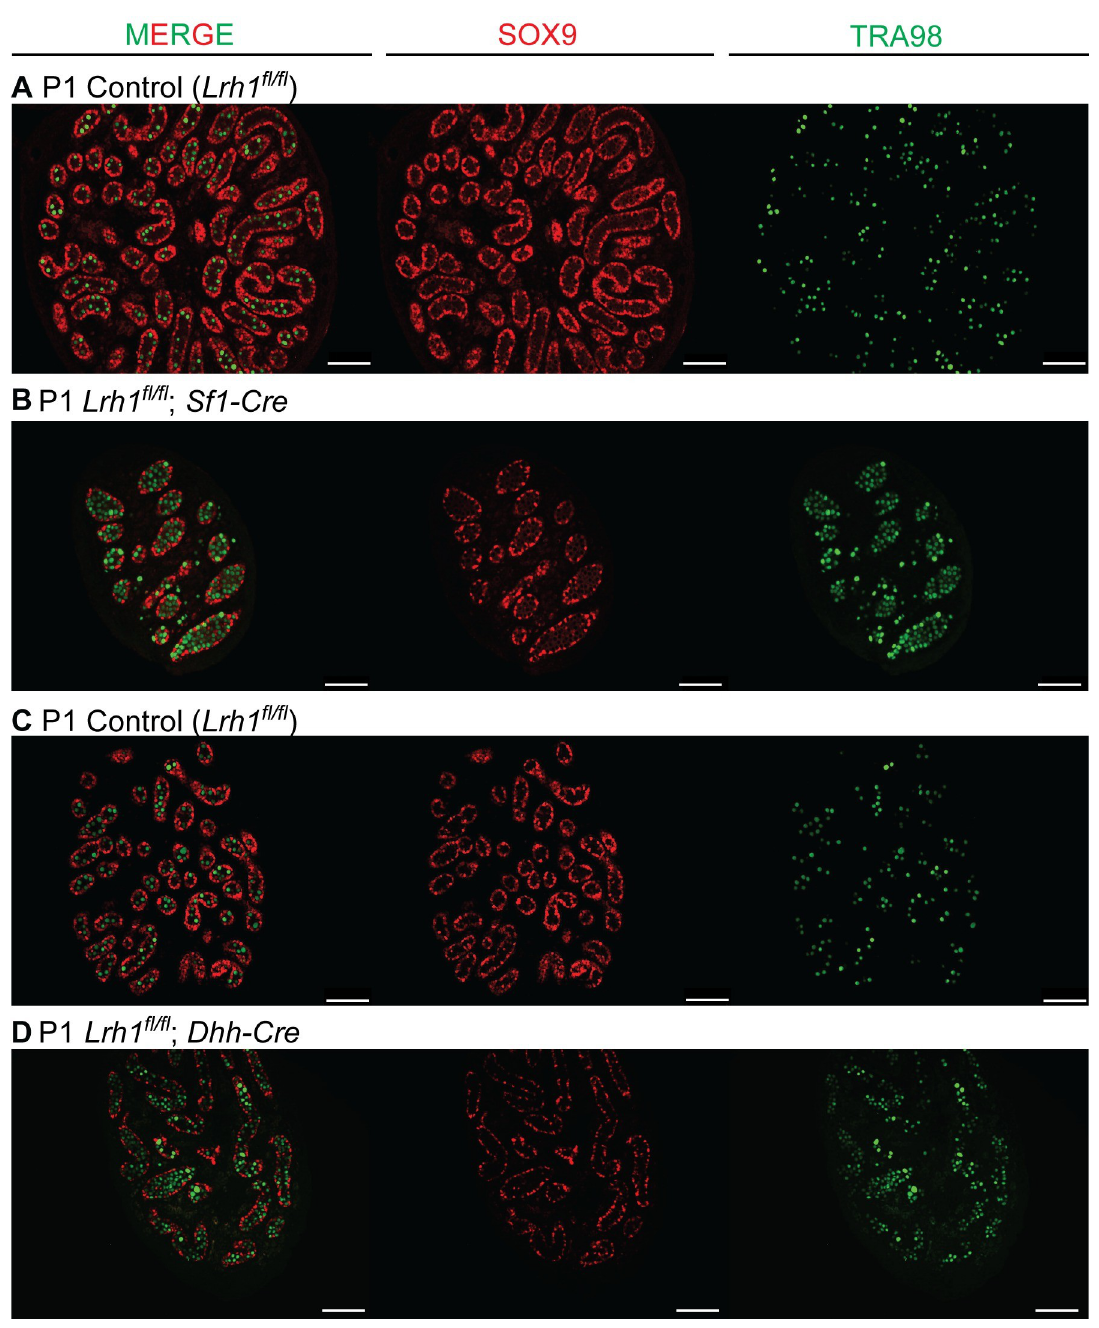
Fig 6. Fetal loss of Lrh1 causes perinatal seminiferous tubule defects. (A,B) IF of P1 control and conditional Lrh1 mutant testes deleted with Sf1-Cre and stained for SOX9 (red), TRA98 (Green) and DAPI (blue). (C,D) IF of P1 control and conditional Lrh1 mutant testes deleted with Dhh-Cre and stained for SOX9 (red), TRA98 (Green) and DAPI (blue). Scale bars: 100 um. of BrdU-positive Sertoli cells at P3 and P5 (Fig 7C and 7D). We performed two-way ANOVA fit followed by post-hoc Tukey’s honest significance difference test. The number of Sertoli cells per area was affected by loss of Lrh1 (p = 5.18 x 10 − 5 ) but not by age (p = 0.441). Proliferation rate determined by the fraction of BrdU-positive cells was affected by both loss of Lrh1